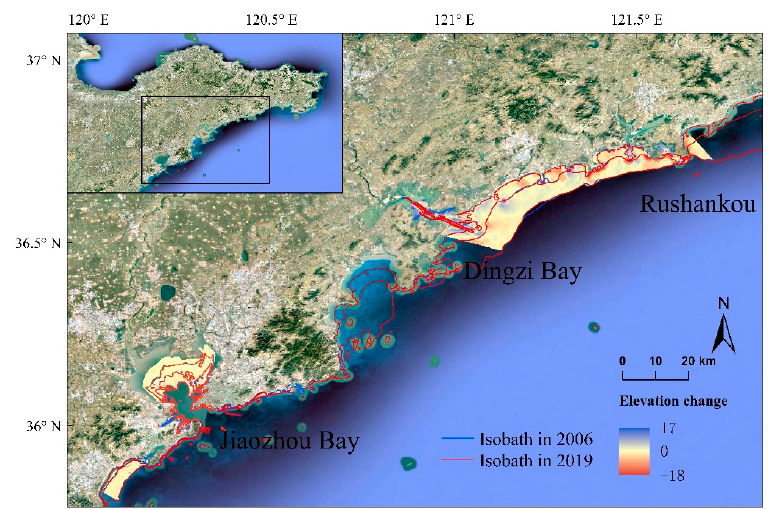
Figure 14. Isobaths and scouring–siltation changes in Rushankou to Dingzi Bay and Jiaozhou Bay.